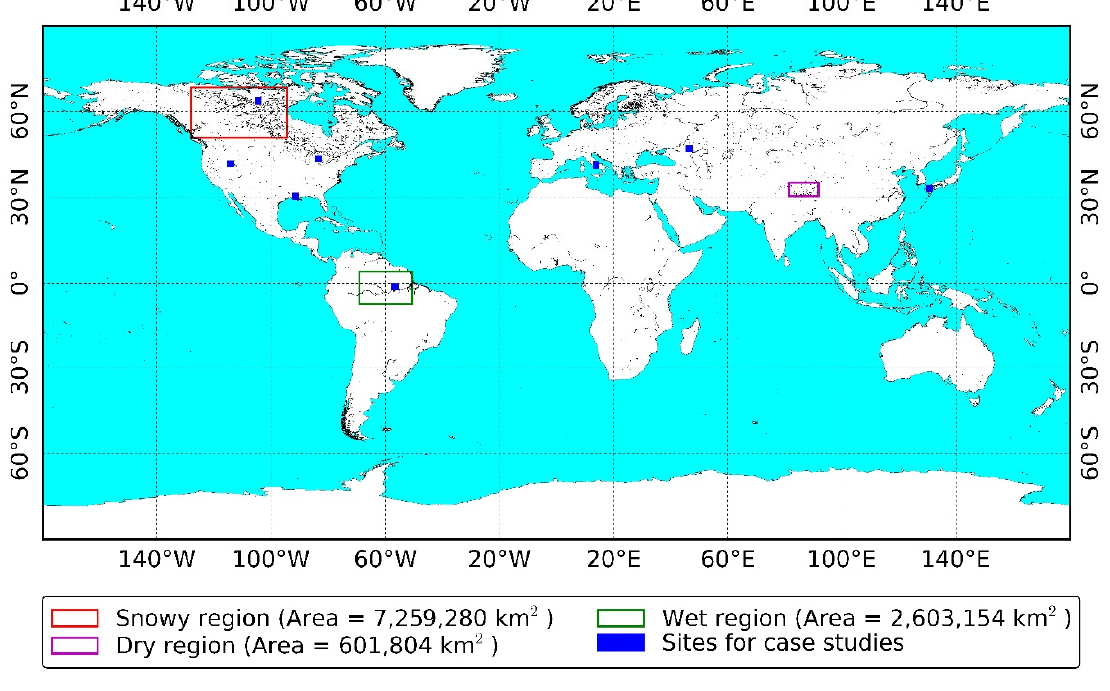
Figure 1. The location map of three regions of interest (ROIs) used for evaluating the water indices, and eight sites used for specific case